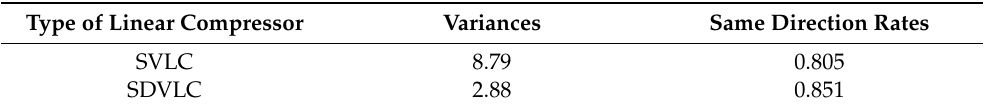
Table 6. Comparison of the variance and same direction rate between the SVLC and SDVLC obtained by experiment.